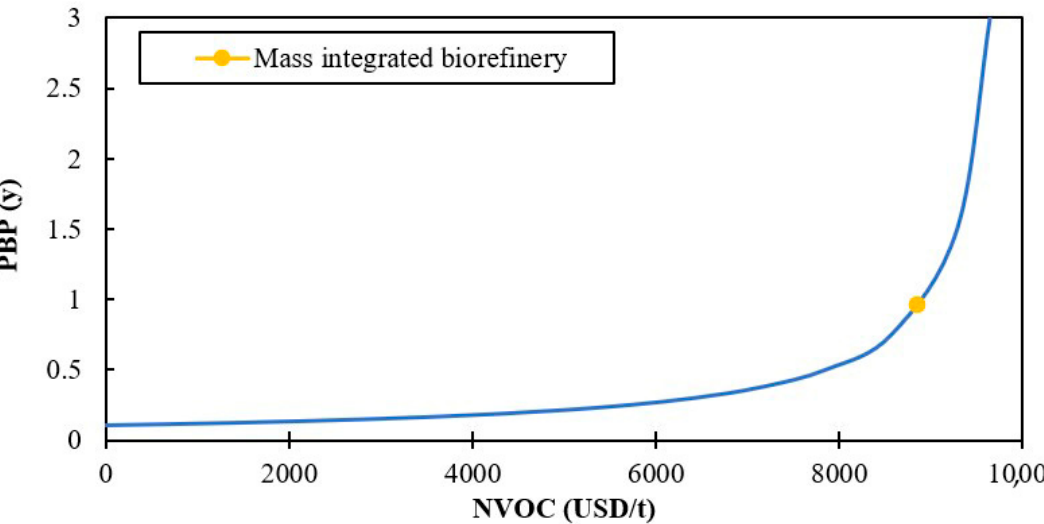
Figure 6. The e ff ect of variable operating cost on return on investment. Figure 6. The effect of variable operating cost on return on investment.